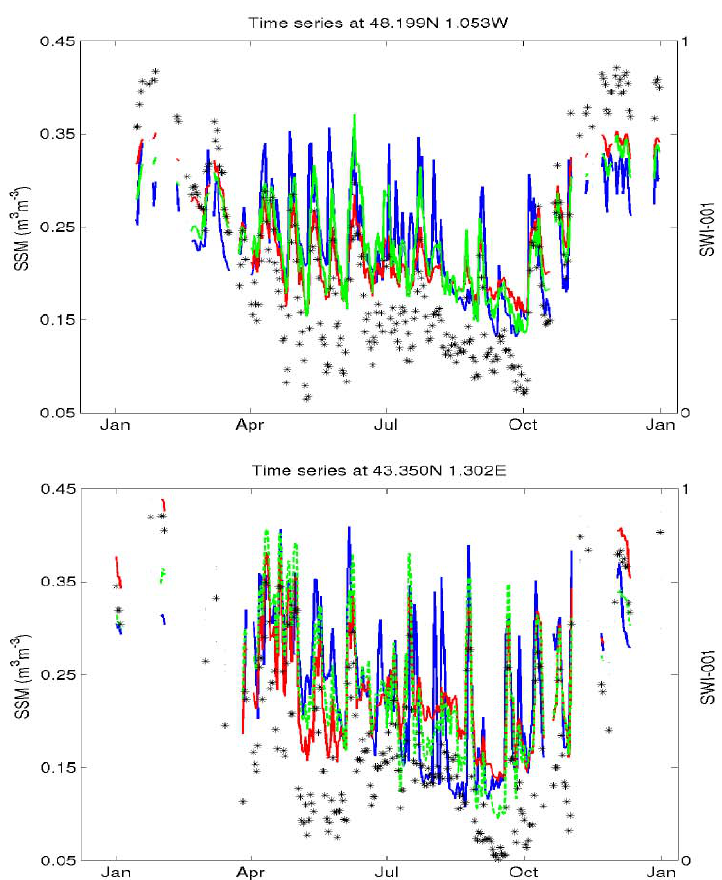
Fig. 2. Surface soil moisture evolutions for 2009 at a location in the north-east (top panel) and a location in the south-west (bottom panel) of France for model (blue), ASCAT CDF rescaled (red) and ASCAT seasonal CDF rescaled (green) observations. SWI-001 observations ranging between 0 and 1 are depicted by black